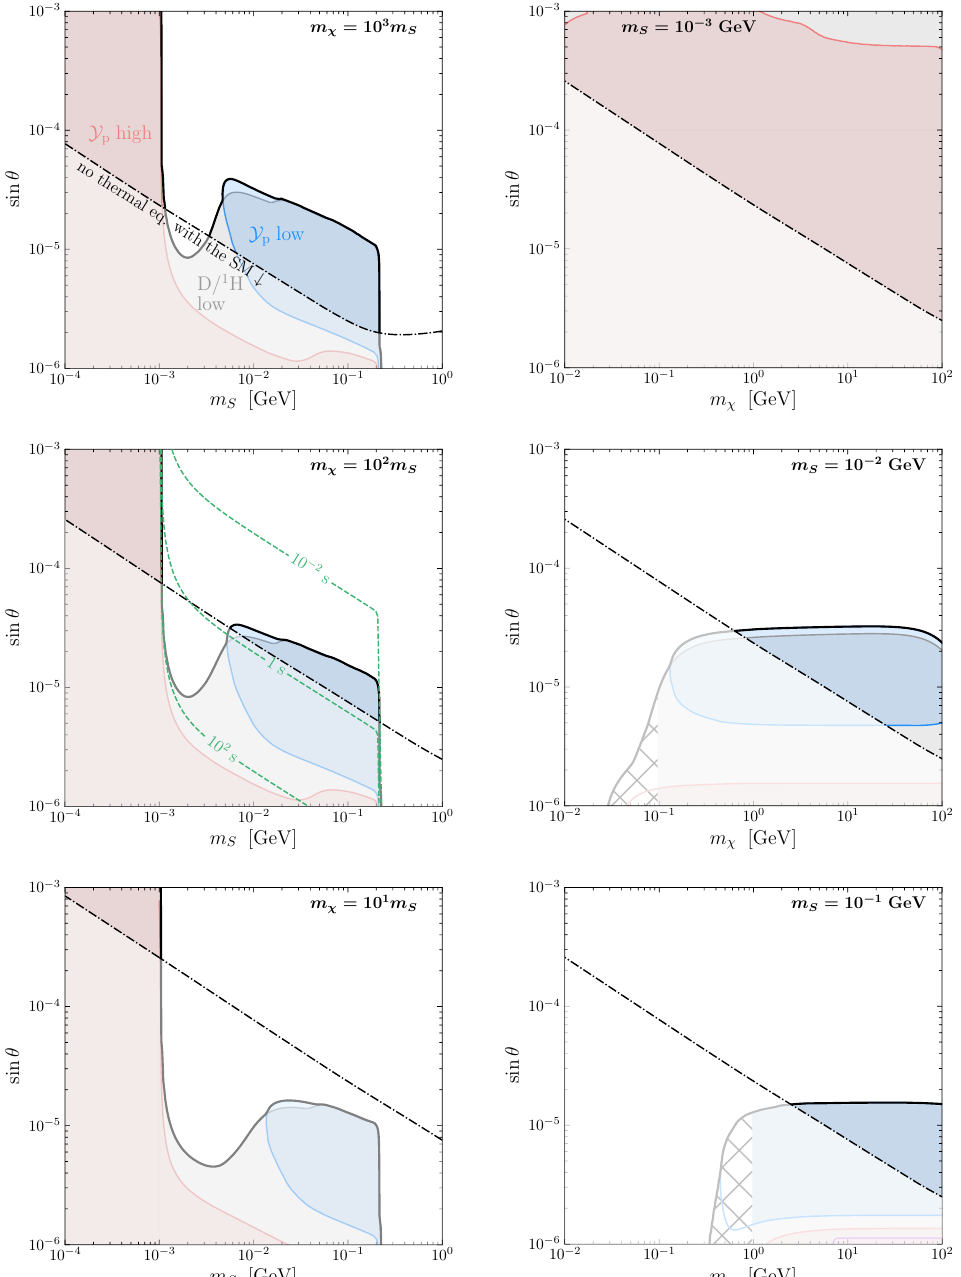
Figure 4 . Limits from BBN as a function of m S and sin (cid:18) for (cid:12)xed ratios m S =m (cid:31) (left panels) and as a function of m (cid:31) for (cid:12)xed masses m S (right panels). Below the dashed black line, the Higgs portal by itself is insu(cid:14)cient to ever thermalise the dark sector with the SM. In addition to the overall limit (solid black line), we also separately show the regions of parameter space which are excluded due to D underproduction (grey), D overproduction (purple) and/or 4 He underproduction (blue), 4 He overproduction (pink). For m S & 0 : 1 m (cid:31) the thermal evolution is not fully captured by our calculation and thus the limits are only approximate, as indicated by the hatch pattern.